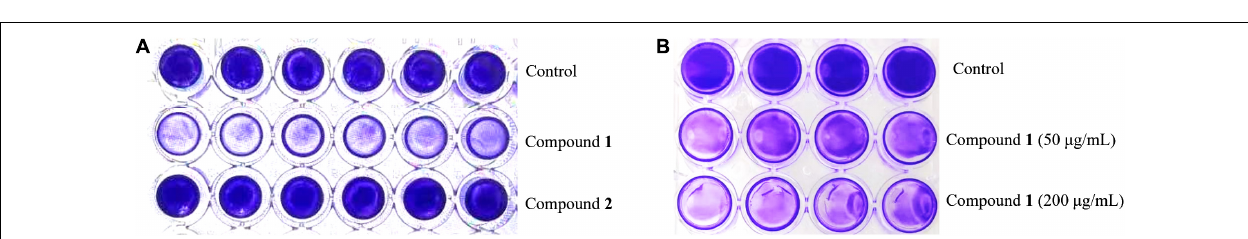
FIGURE 1 | Chemical structures of anthraquinones mentioned in the article. Compounds 1 and 2 were isolated from Kitasatospora albolonga R62 and compounds 3 – 12 were commercially obtained.